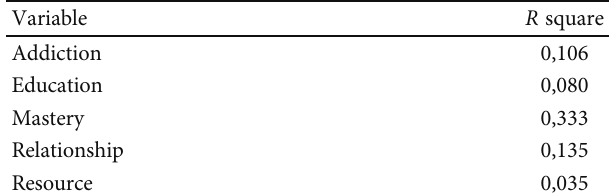
Table 6: R -squared